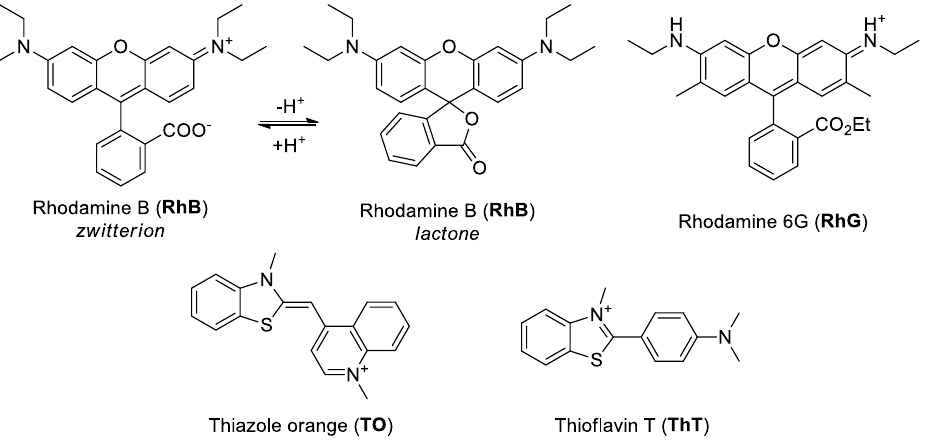
Figure 1. Structure of ligands directly used in this study.